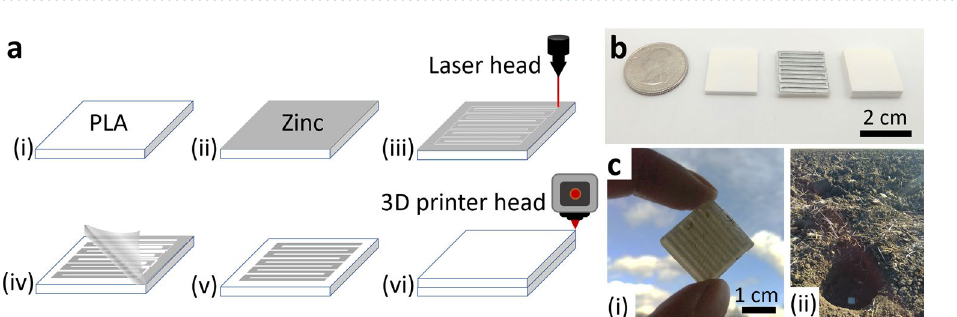
Figure 3. ( a ) Conceptual illustration of the fabrication of DIRTS (i) 3D printed PLA substrate (ii) Zinc tape attached to the top of the PLA substrate (iii) Laser cutting the zinc layer to engrave a meander line pattern (iv) Removal of excessive zinc tape from the surface (v) Meander line structure on the PLA substrate after the removal of the remnant zinc tape (vi) 3D printing the PLA superstrate to passivate the sensor tag. ( b ) Images of DIRTS in its various stages of fabrication. ( c )Images of DIRTS that demonstrate (i) significant size reduction and (ii) portability for field